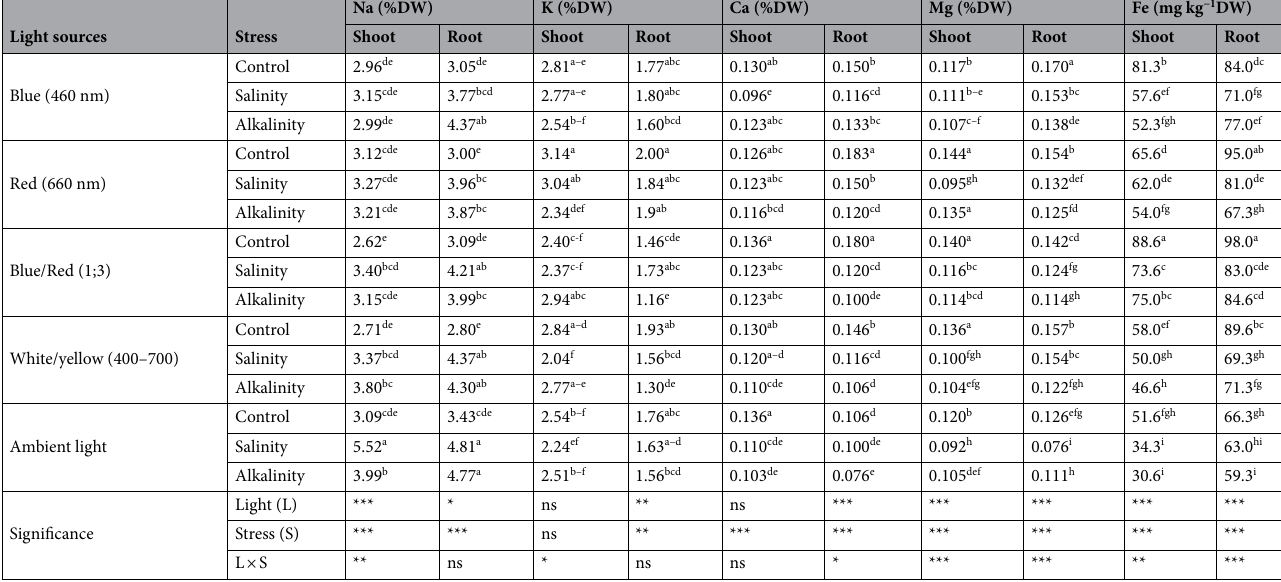
Table 6. Interaction of five levels of light spectrum and three levels of stress treatment on nutrient element concentration of strawberry cv. Camarosa. Values are means ± SE of three replicates. Bars with different letters show significant differences at P ≤ 0.05 (Duncan). Significance according to ANOVA, ns, *, **, ***, no significant and significant P ≤ 0.05, 0.01, 0.001, respectively. Control (no stress), salinity (80 mM NaCl) and alkalinity (40 mM NaHCO 3 ). Photon flux density (PPFD) 200 ± 10 mmol_m –2 s –1 . SAS software version 9.4 was used for data